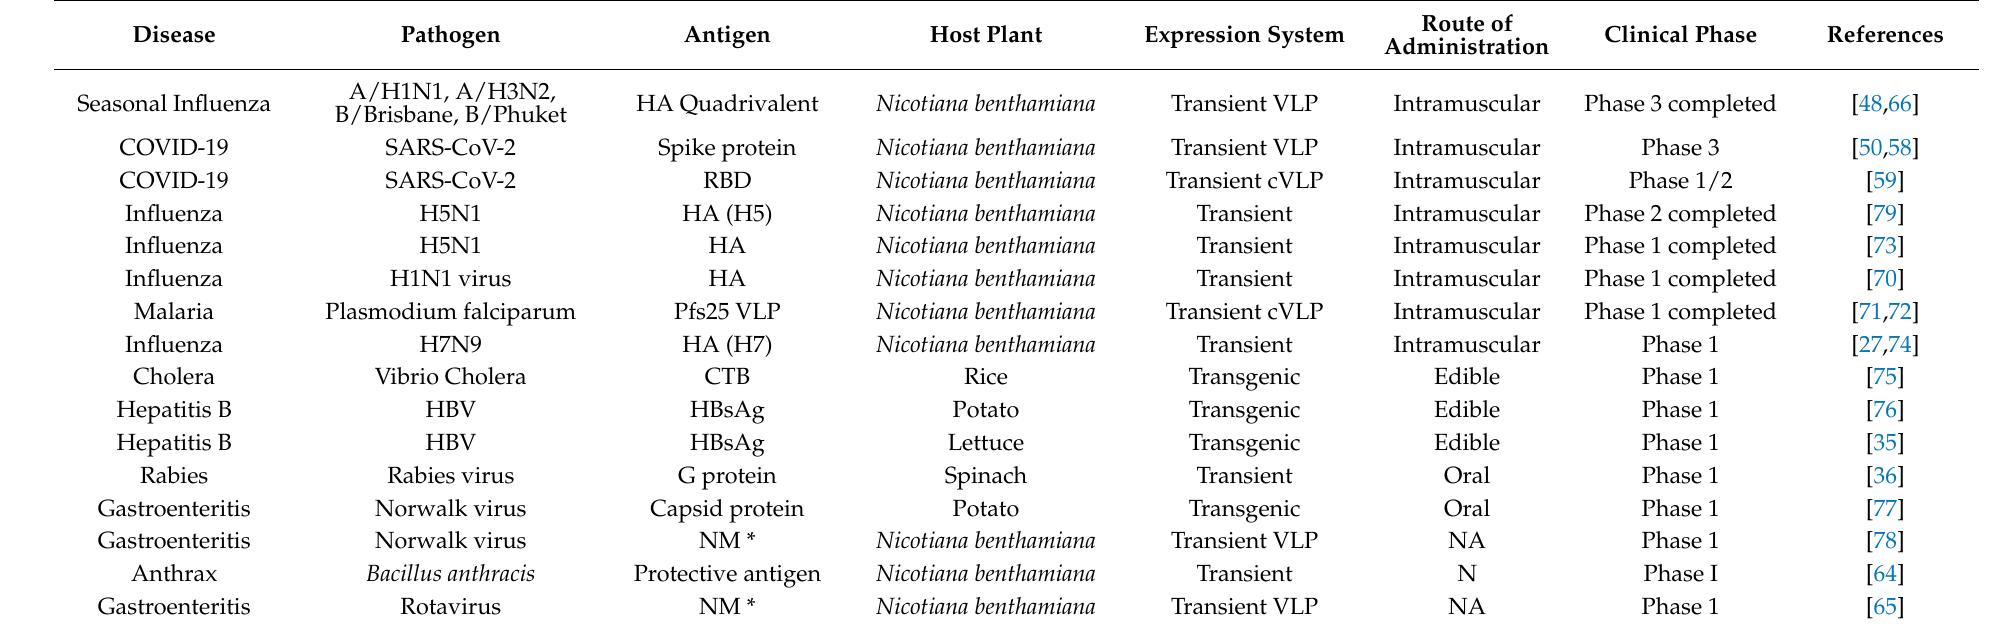
Table 2. Plant-based vaccines in clinical